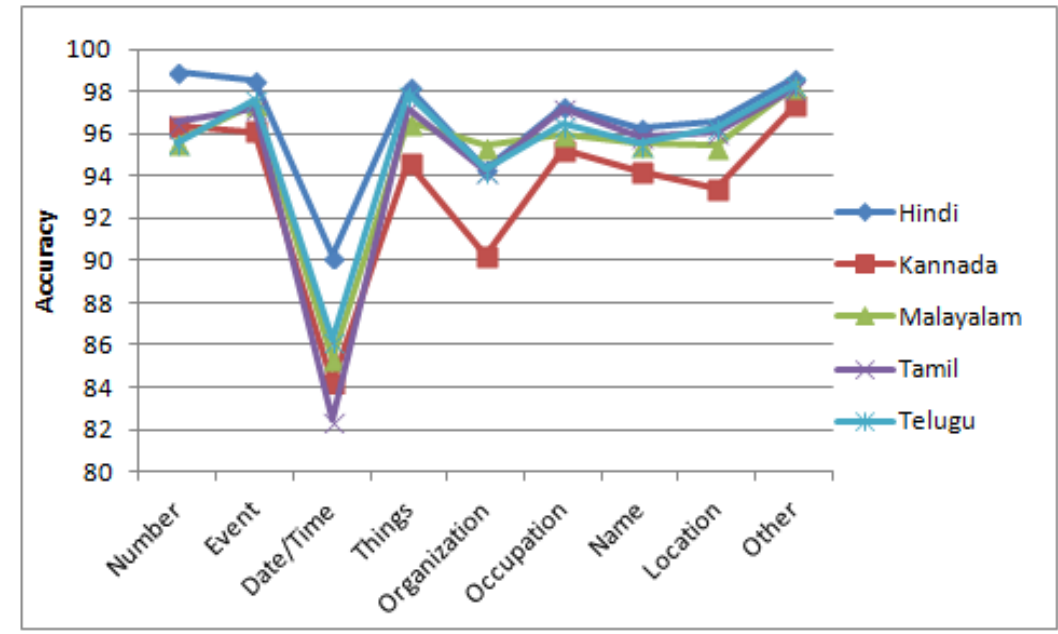
Figure 6. Class-wise accuracy scores for all the languages present in the shared